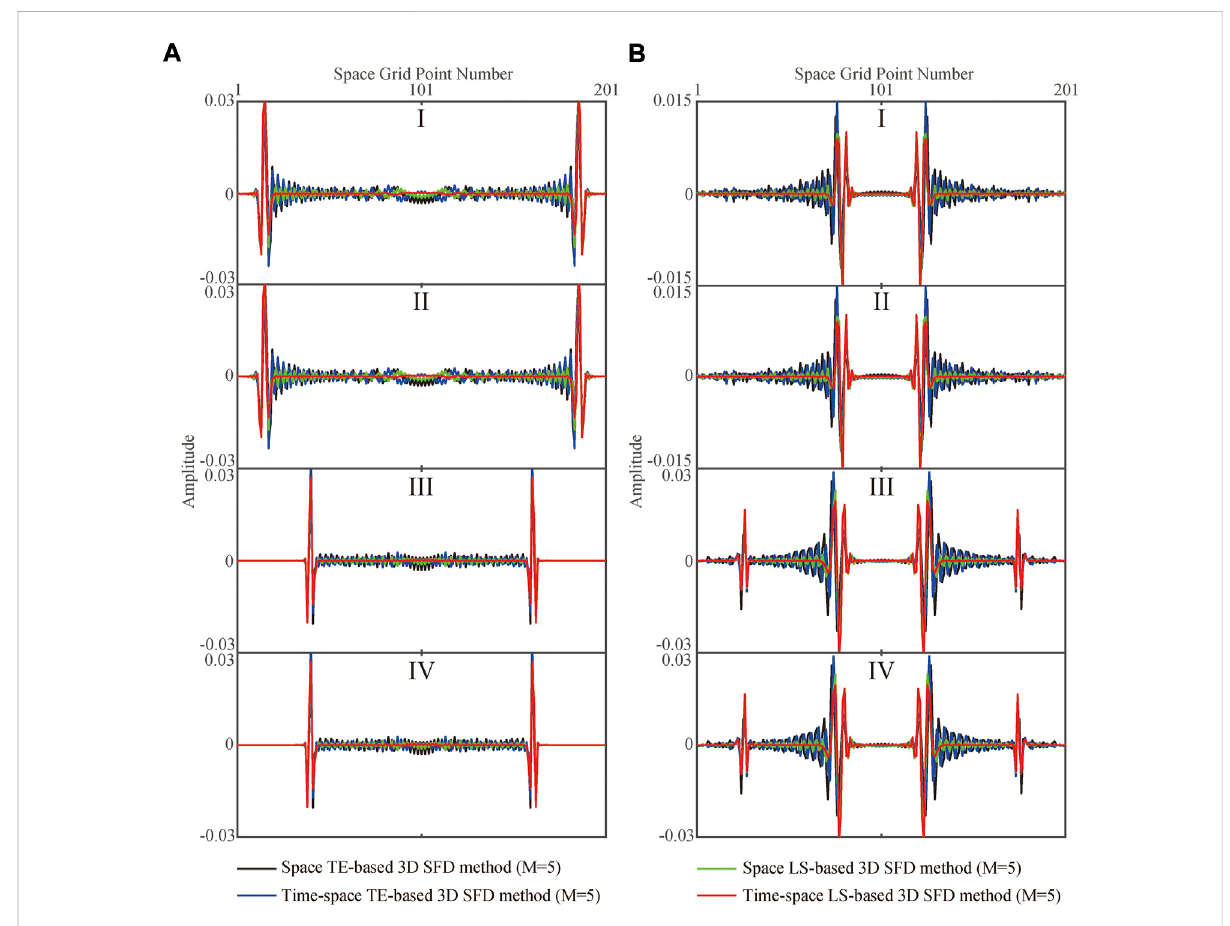
FIGURE 7 Waveform curves of the 2D snapshots ( M (cid:2) 5) shown in Figure 5 for the simple 3D homogeneous acoustic model (Model B). (A) Waveform curves of the 2D snapshots at 0.6 s. (B) Waveform curves of the 2D snapshots at 1.4 s. I, II, III and IV represent the different directions shown in Figure